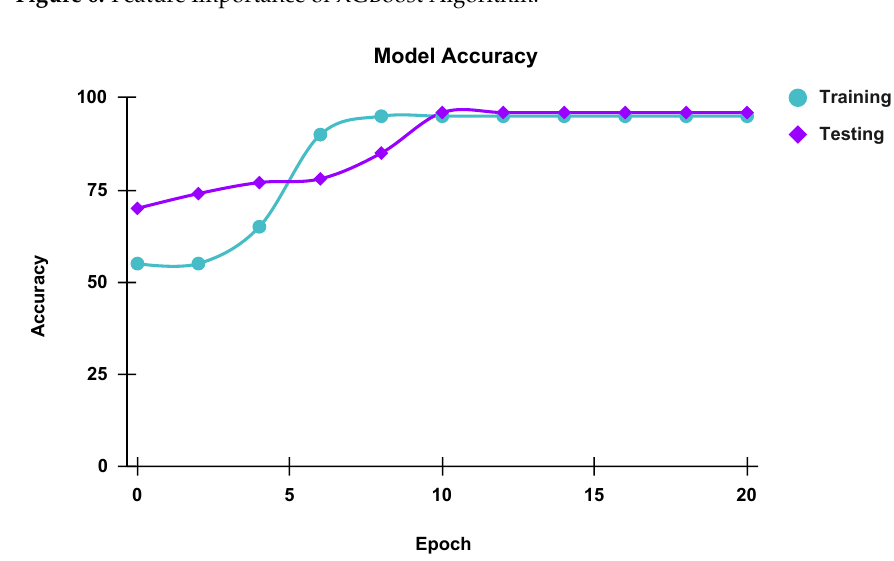
Figure 7. Training and validation accuracy of Neural